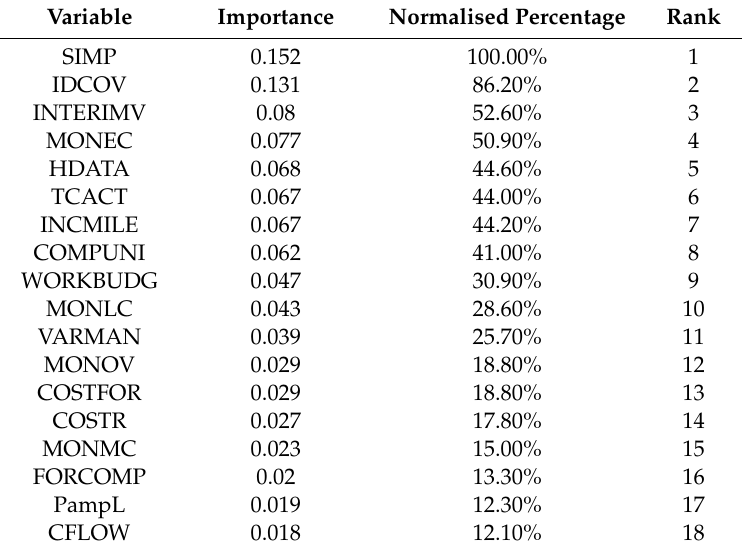
Table 10. Validated normalised importance of the post-contract cost controlling techniques. Variable Importance